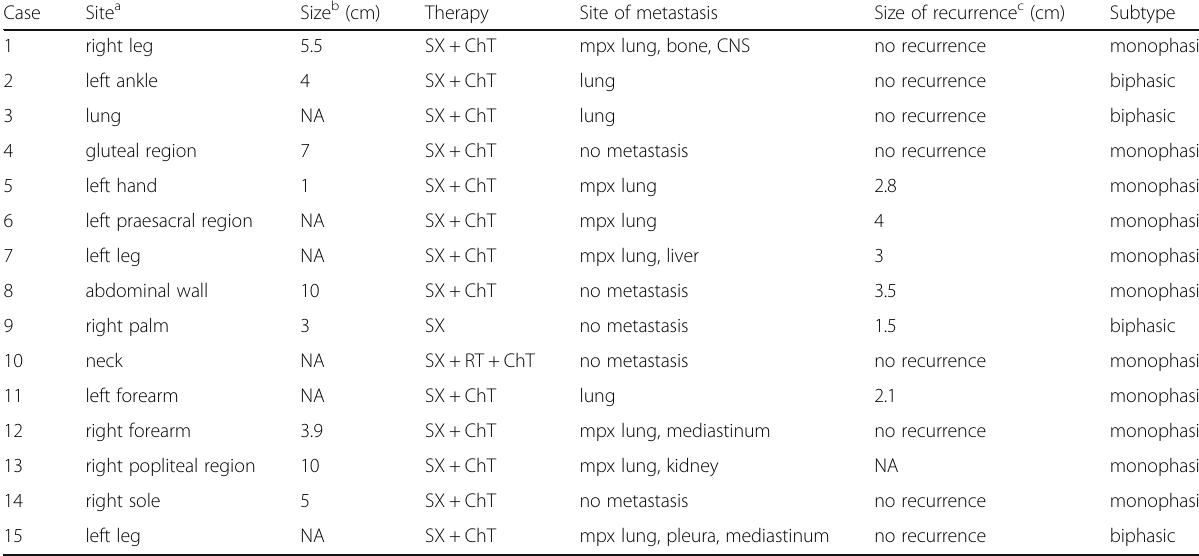
Table 1 Clinical characteristics of the synovial sarcoma cohort